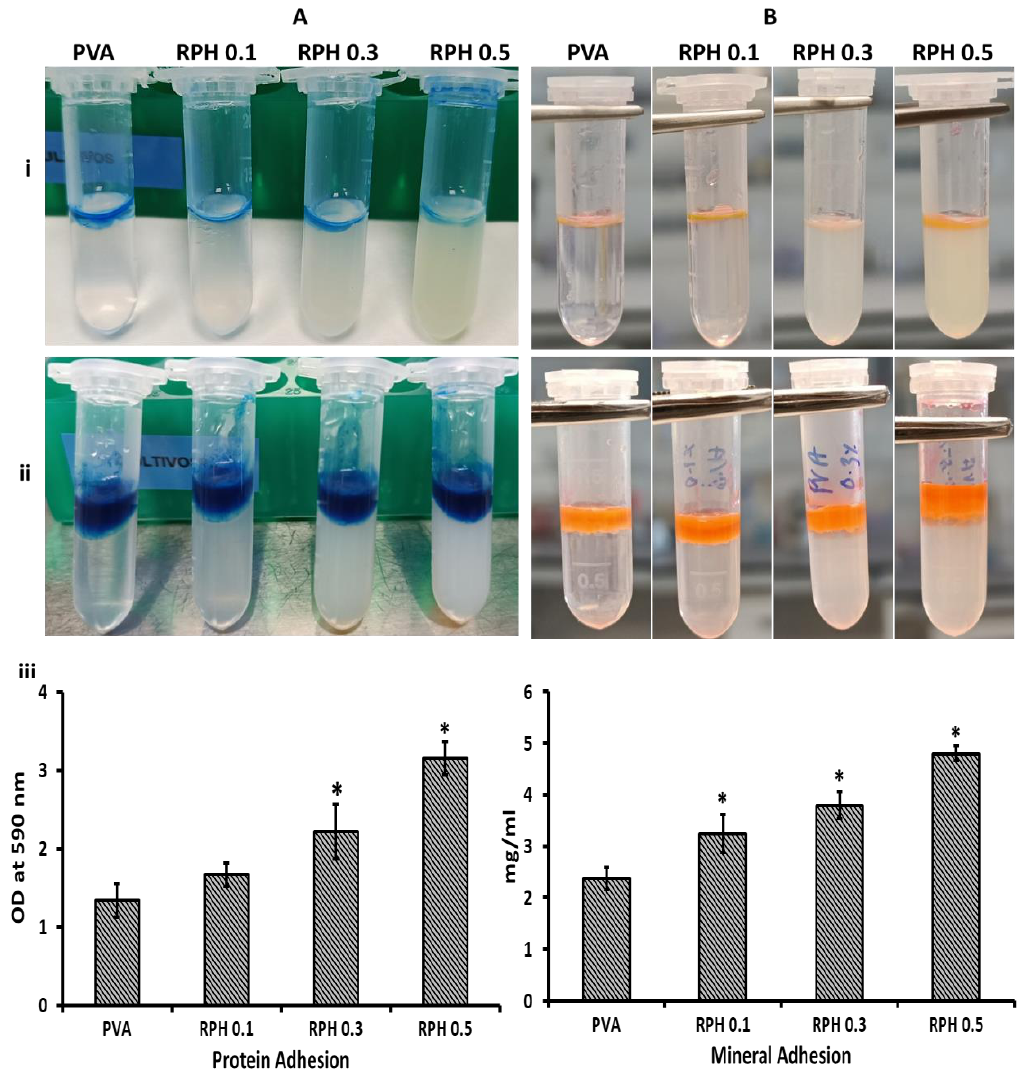
Figure 4. The upper panel shows representative macroscopic images of the RPHX hydrogels stained for protein and mineral adhesion assessments. The lower panel shows Optical Density (OD) measured at 590 nm for both protein ( A ) and mineral adhesion ( B ) assessment in the RPHX hydrogels, respectively. PVA solution 15 wt.%, RPH 0.1-0.1% retinol PVA, RPH 0.3-0.3% retinol PVA, RPH 0.5-0.5% retinol PVA hydrogel. (i) Negative control containing PVA/retinol without FBS or biomimetic mineral treatment, (ii) Test samples with FBS or biomimetic mineral treatment, and (iii) UV absorption of protein and mineral adhesion (No UV absorption was observed in negative control samples). * represents statistical significance, * p < 0.05 vs. PVA.